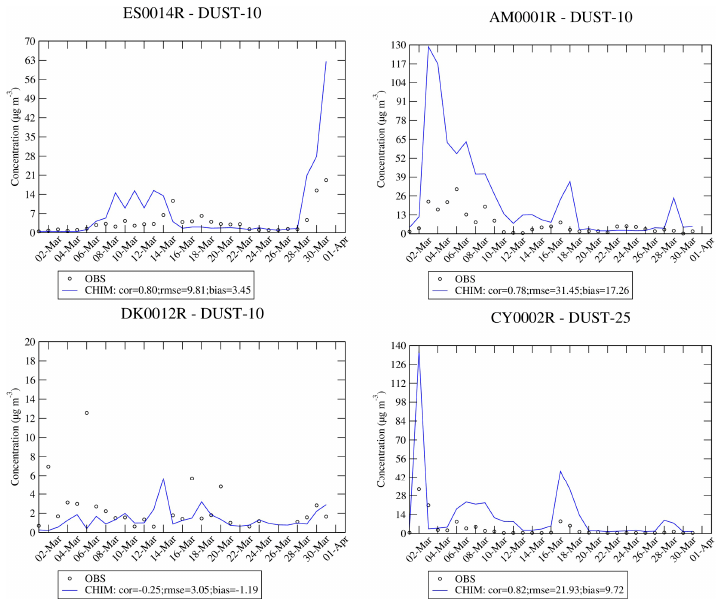
Figure 13. Daily time series of dust concentrations (in the PM 10 or PM 2.5 matrix) for four sites in Europe in March 2014 (ES0014R 41.40° N–0.72° E Els Torms, Spain; AM0001R 44.26° N–40.38° E Amberd, Armenia; DK0012R 55.69° N–12.09° N–E Risoe, Denmark; CY0002R 35.04° N–33.06° E, E Ayia Marina, Cyprus).